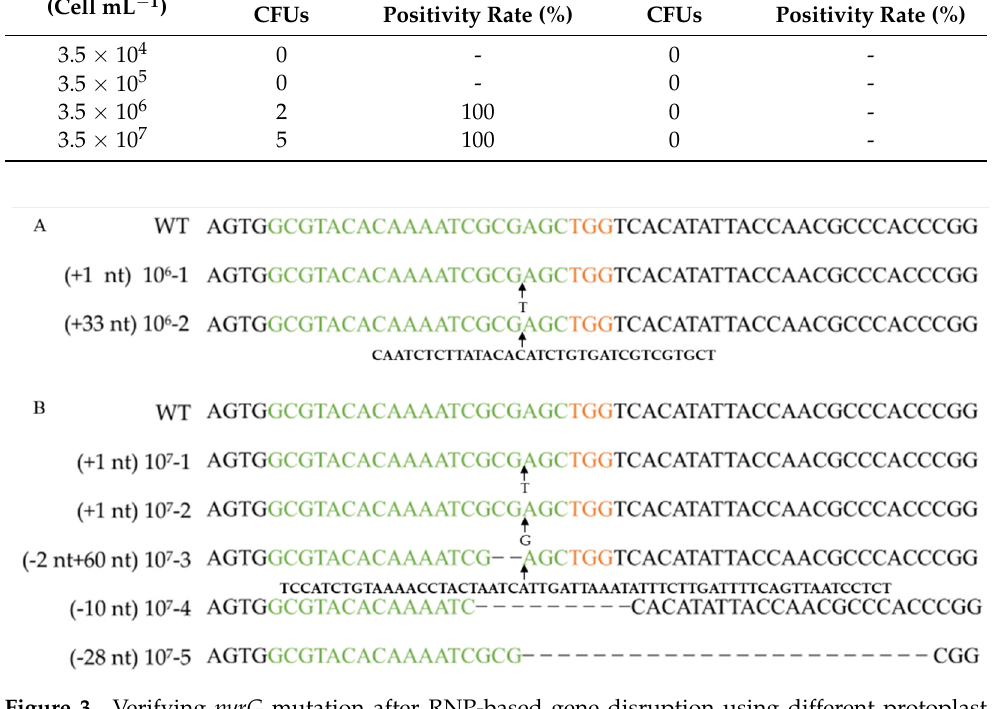
Figure 3. Verifying pyrG mutation after RNP-based gene disruption using different protoplast concentrations. Alignment of pyrG sequences and corresponding mutants obtained by transformation with 10 6 cells mL − 1 protoplasts ( A ) and 10 7 cells mL − 1 protoplasts ( B ). WT: wild-type strain Dan3. Concentrations 10 6 -1, 10 6 -2, 10 7 -1~10 7 -5: mutants generated by transformation of RNPs. Green marked represents spacer sequences; orange marked represents PAM.